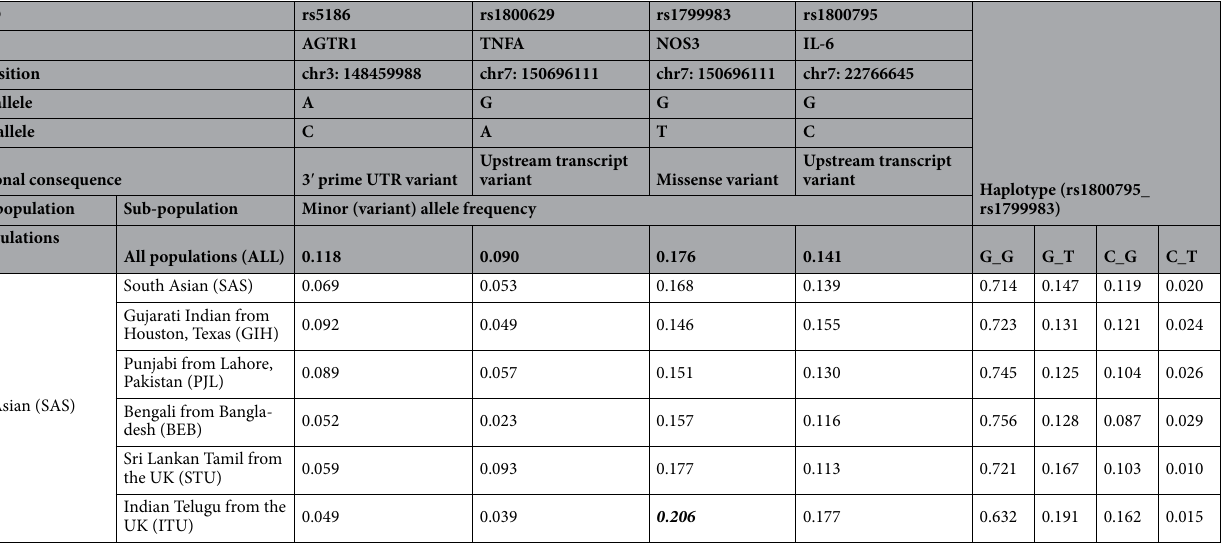
Table 1. Frequencies of rs5186, rs1800629, rs1799983 and rs1800795 variant alleles and haplotypes in world populations.